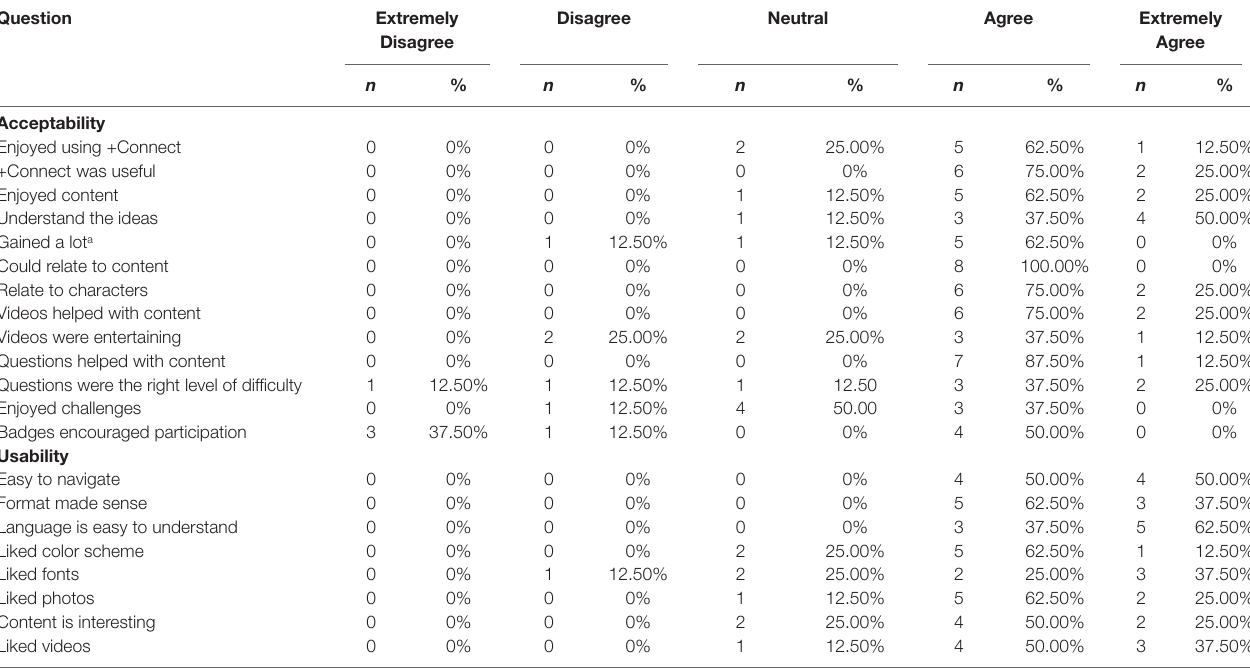
TABLE 8 | Ratings related to functionality, design, and delivery of concepts for the SAD group.